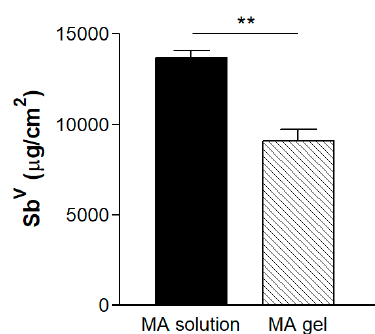
Figure 6. Flux of Sb V released after 55 h through hydrophilic polypropylene membranes (** p < 0.01).